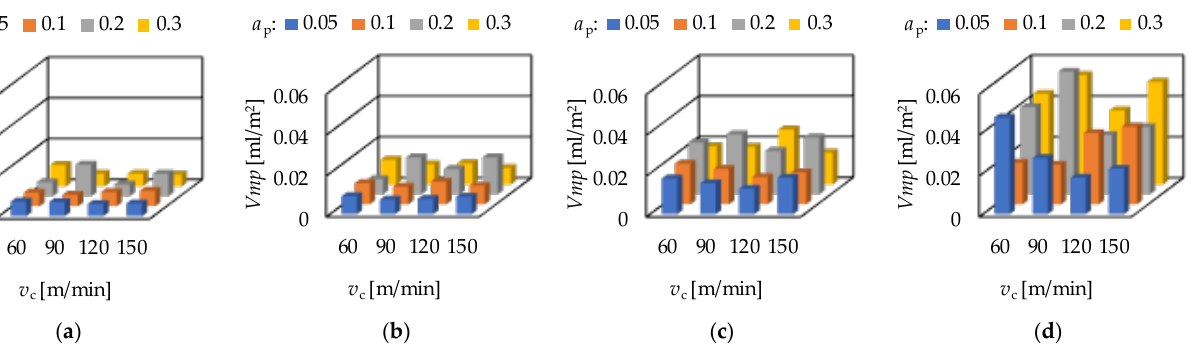
Figure 5. The measured peak material volume ( Vmp ) values for hard turning by applying ( a ) f = 0.05 mm/rev, ( b ) f = 0.1 mm = rev, ( c ) f = 0.15 mm/rev, ( d ) f = 0.2 mm/rev.